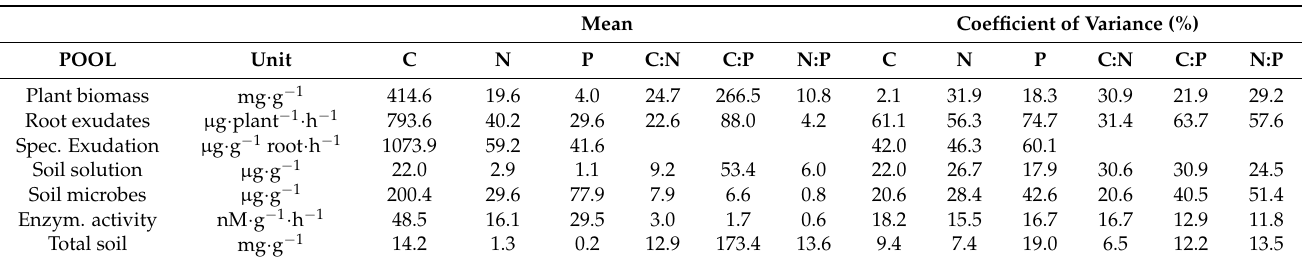
Table 1. C, N, P contents and their molar ratios in plant, microbial, and soil pools calculated over all planted treatments (mean and coefficient of variance in %, n =